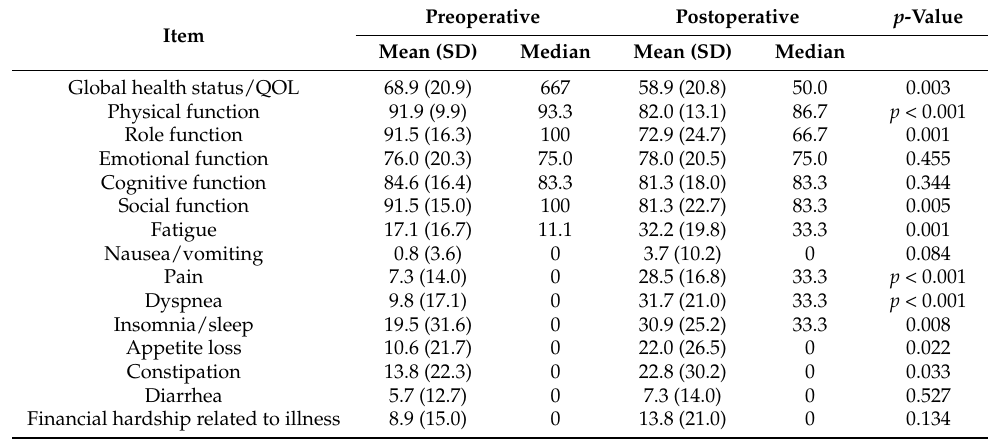
Table 3. Comparison of QLQ-C30 between pre- and postoperative lung